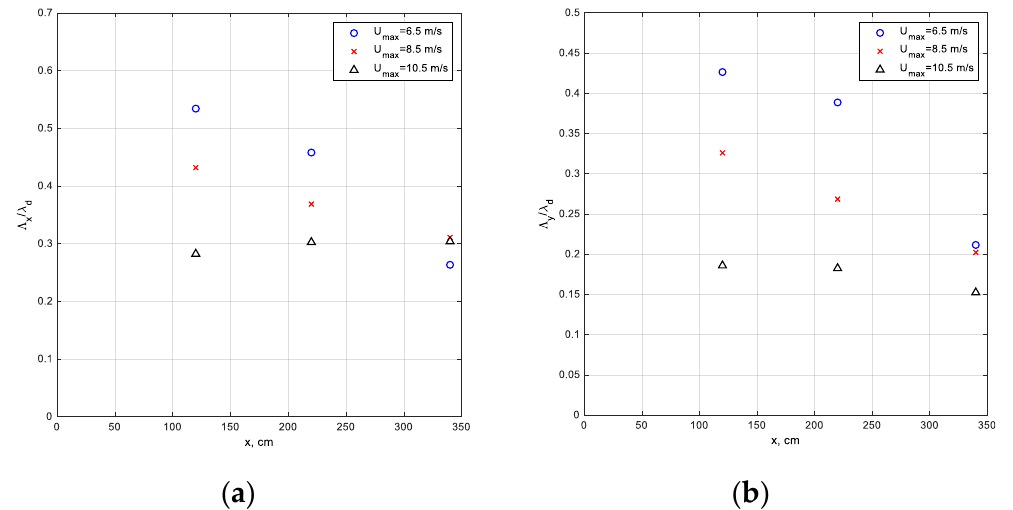
Figure 15. The normalized by the local dominant wavelength λ d integral length scales in the ( a ) along-wind and ( b ) cross-wind directions.